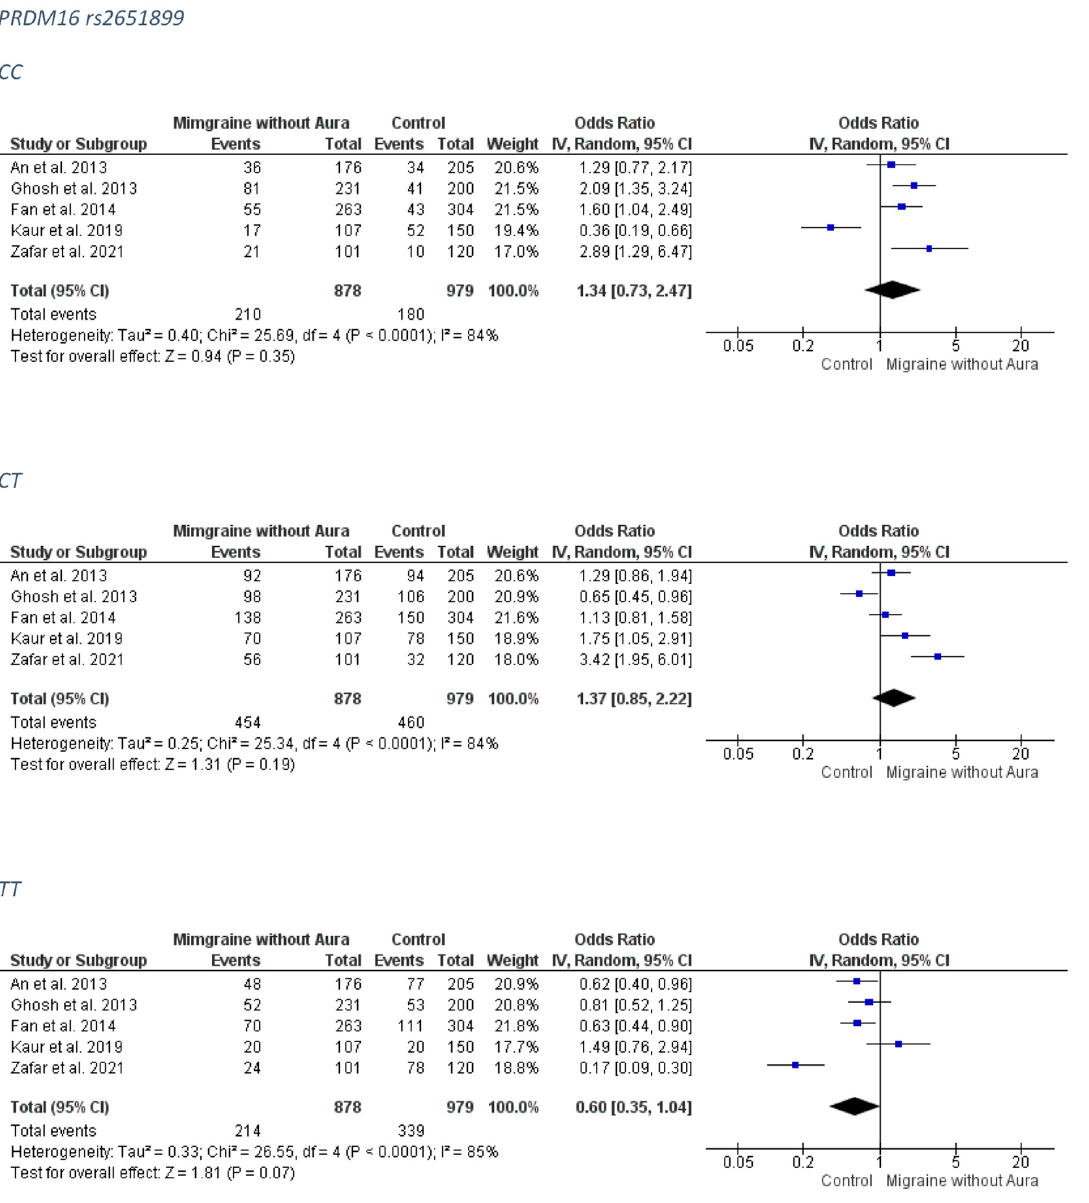
Figure 3. The forest plots presenting the results from meta-analysis of the rs2651899 and migraine without aura group.